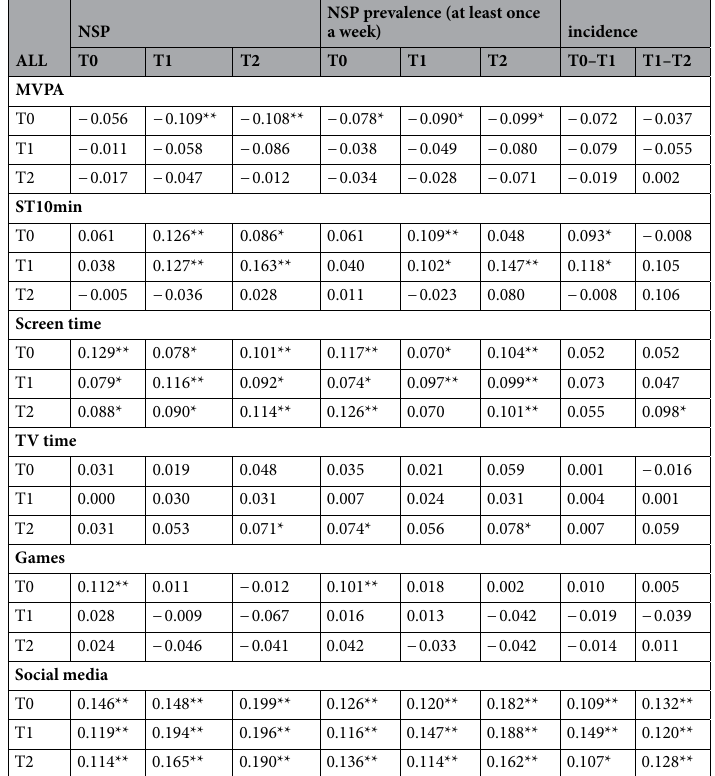
Table 2. Pearson correlation coefficients between variables and neck and shoulder pain (NSP) at T0, T1 and T2 for all participants. * p < 0.04, ** p < 0.05, MVPA = Moderate to vigorous physical activity (≥ 2296 cpm); ST10min = sedentary time of at least 10 min (< 100